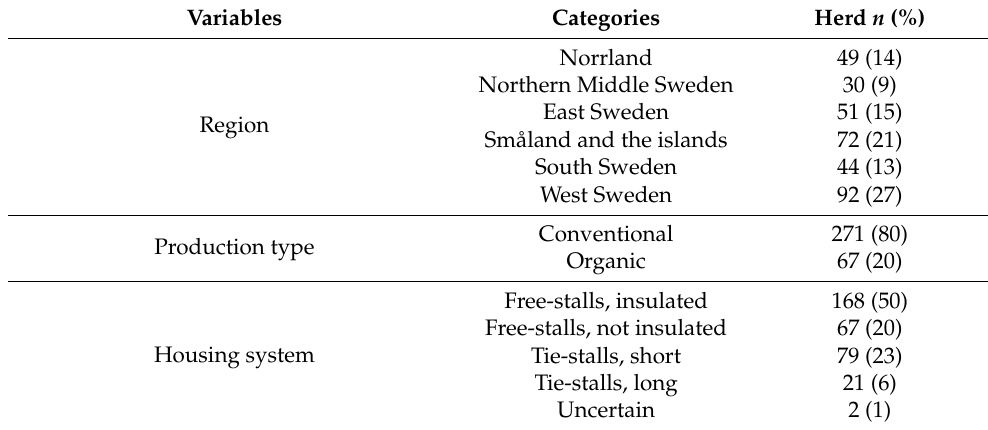
Table 1. Distribution of herds ( n = 340) participating in a web-based questionnaire on routines for drying-off and dry period among herd